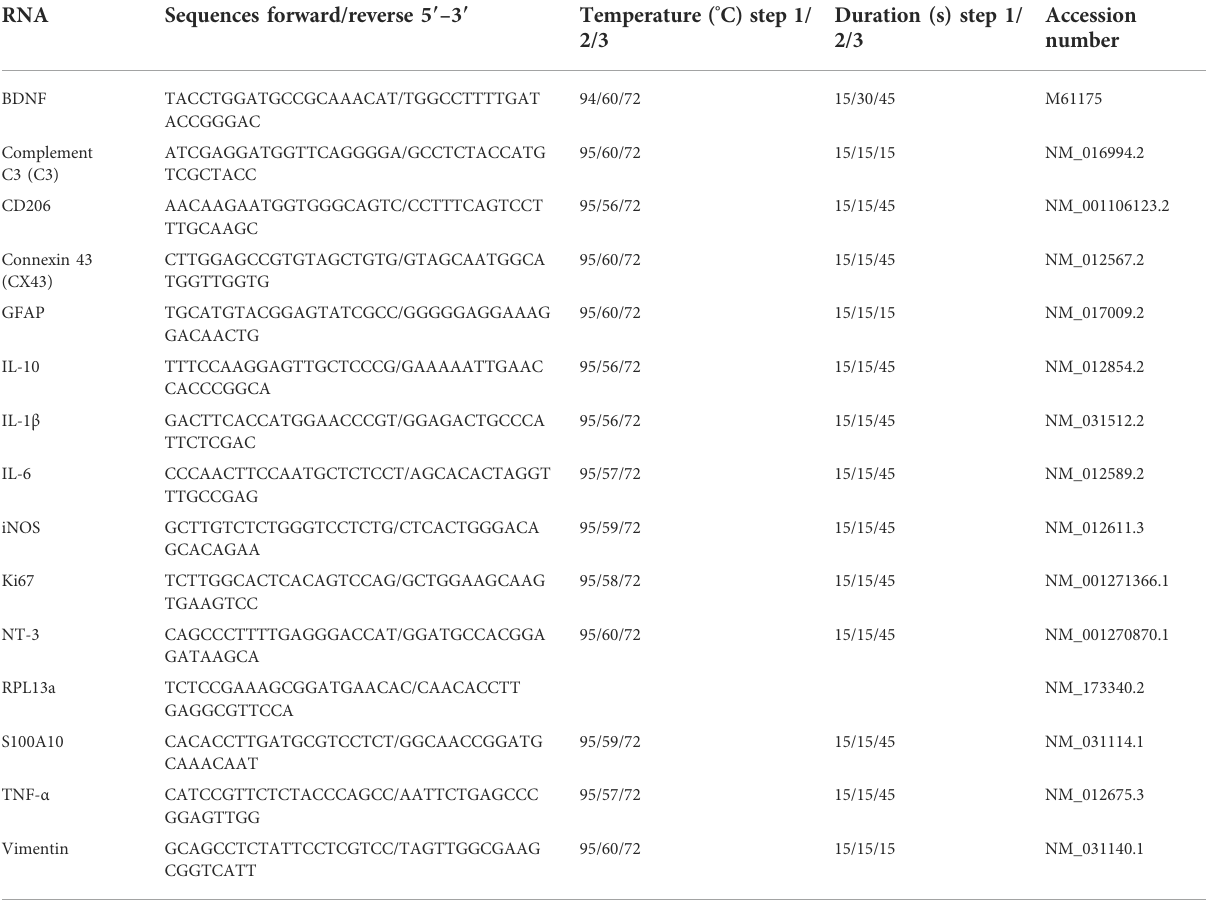
TABLE 1 Used primers and parameters of RT-qPCR.